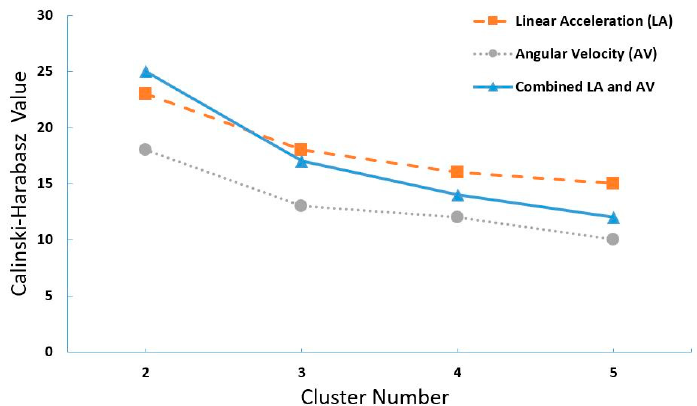
Figure 2. Calinski–Harabasz index for different features including linear acceleration, angular velocity, and the combination of them, for different number of clusters.